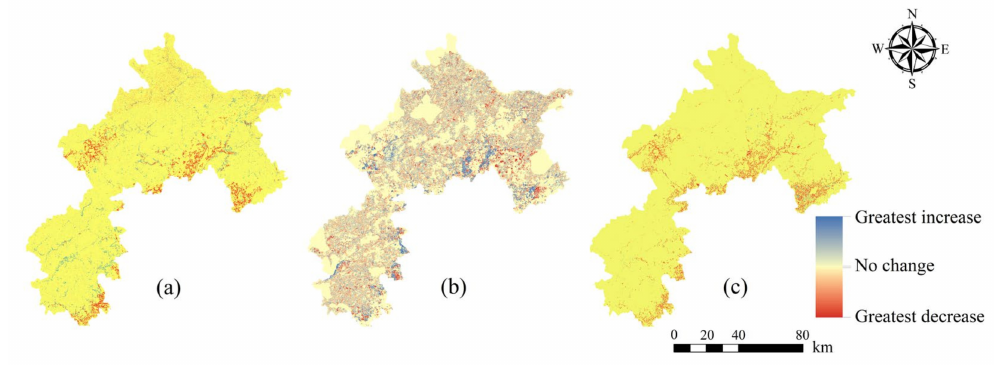
Figure 5. The spatial distribution of sum of ecosystem services (SES) changes from 2015 to